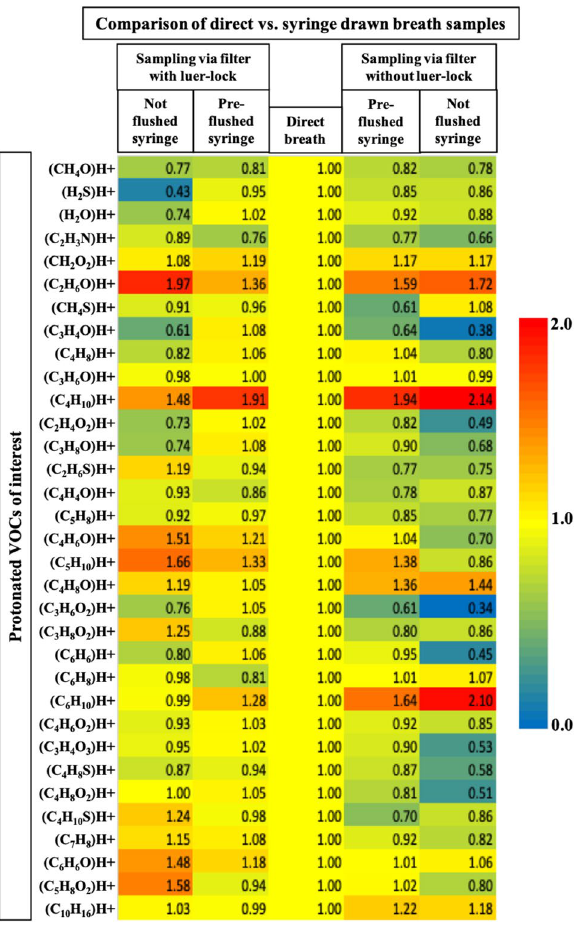
Figure 4. Effects of viral filters on side-stream manual sampling with different connection types with and without pre-purging: syringe drawn breath was analysed via PTR-ToF–MS and compared to direct PTR-ToF analysis. Y-axis represents protonated VOCs of interest. X-axis represents experimental conditions. VOCs data from syringe samples were normalised onto the corresponding values without filter. Syringe filters with and without luer-lock were compared. Effect of flushing and not flushing syringes prior to sampling are observed. Changes in colour represents relative changes in concentrations. Red and blue colour represents relatively high and low values,